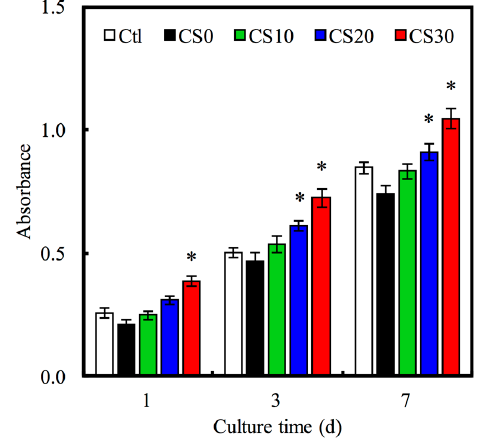
Figure 9. The proliferation of hMSCs cultured with various specimens for different time-points. “*” indicates a significant difference ( p < 0.05) compared to CS0.